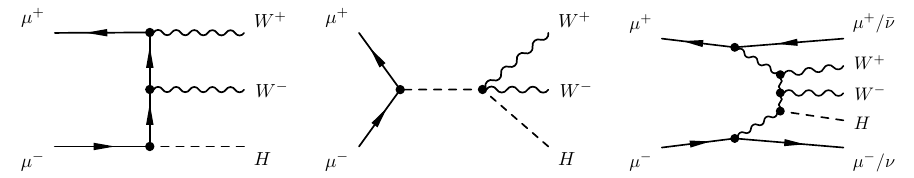
Figure 8 . Representative diagrams for the signal annihilation process µ + µ − → W + W − H (left and middle), and for the VBF background process (right).